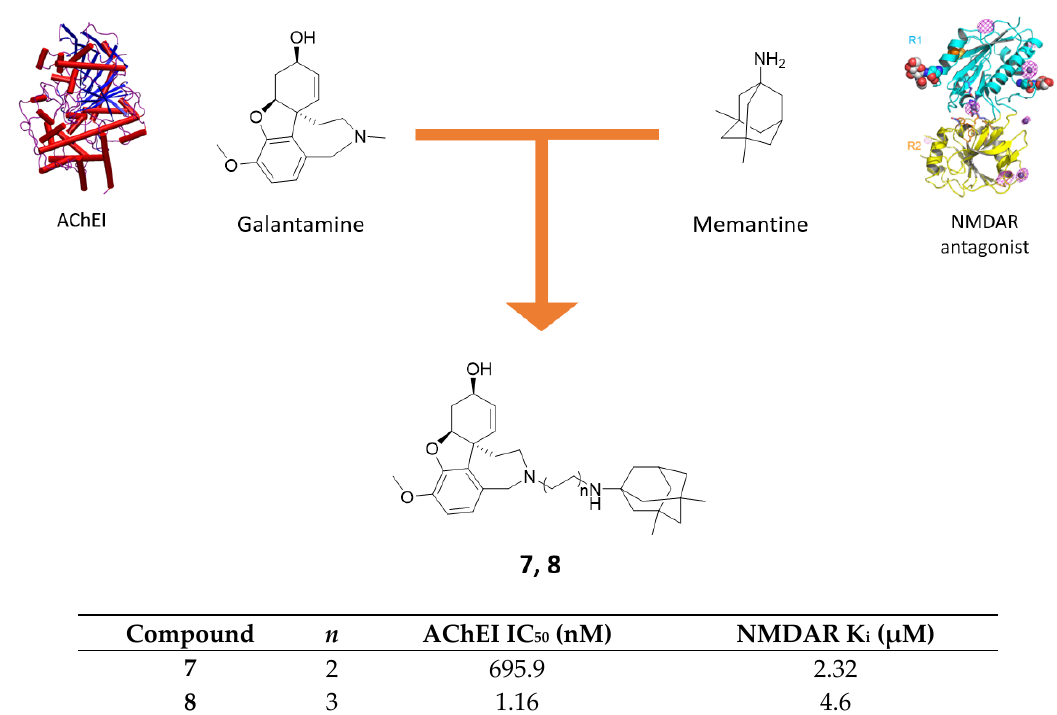
Figure 5. Drug design and biological activities of memantine-galantamine hybrids 7 and 8 .